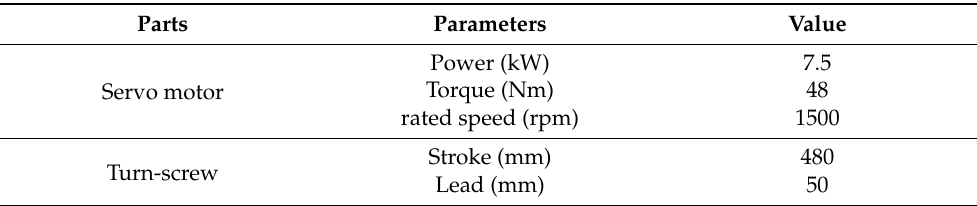
Table 2. The parameters of the stroke amplifying mechanism.